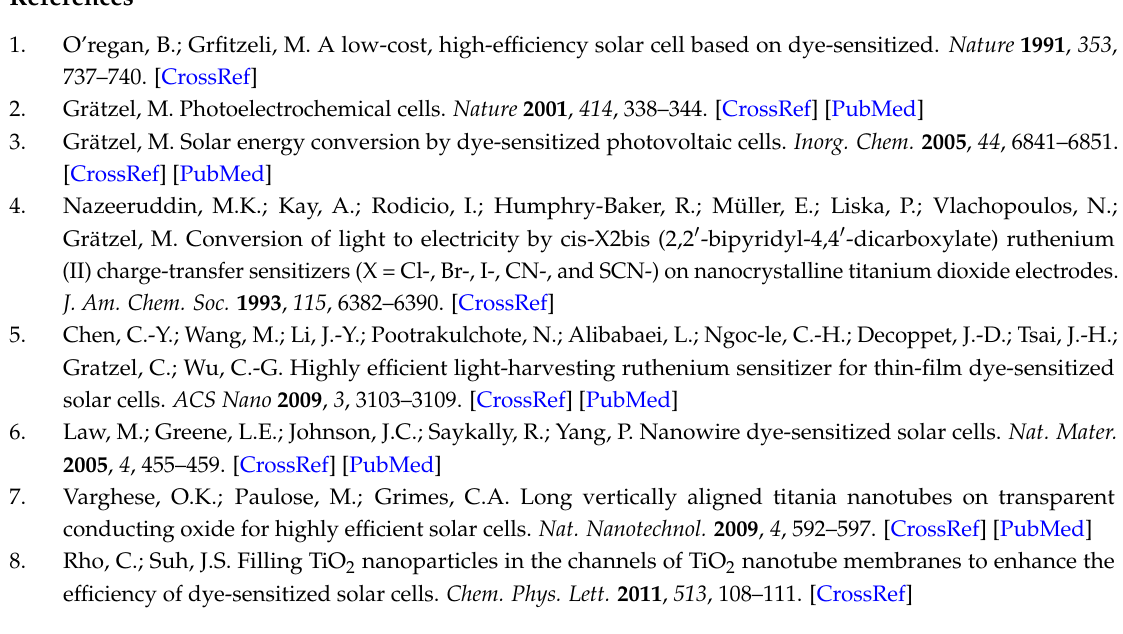
Figure S1: The cross-section image of SEM by photoanode in DSSC based on layer-by-layer structure. The thicknesses of the 1 st TiO 2 layer (bottom), 2 nd TiO 2 layer (middle) and scattering layer (top) were 5.44 µ m, 4.83 µ m, and 5.67 µ m, respectively, Figure S2: The EDX spectra of (a) TiO 2 film immobilized Au NPs, (b) TiO 2 film immobilized Ag NPs and (c) TiO 2 film immobilized Ag and Au NPs based on layer-by-layer structure, Figure S3: The SEM images and size distribution histograms of (a) immobilized Ag NPs and (b) immobilized Au NPs on film. The average size of Ag and Au NPs is 29 ± 1.8 nm and 19 ± 1.5 nm, respectively, Figure S4: Simulated electric field intensity distributions of (a) Au and (b) Ag NPs under the excitation at their plasmon wavelengths in layer-by-layer structure calculated by the finite difference time-domain (FDTD) method, Figure S5: Dark current characteristics of DSSCs based on the layer-by-layer structure (a) without metal nanoparticles (NPs), (b) with spherical Ag and Au NPs, and (c) with multi-shaped Ag and Au